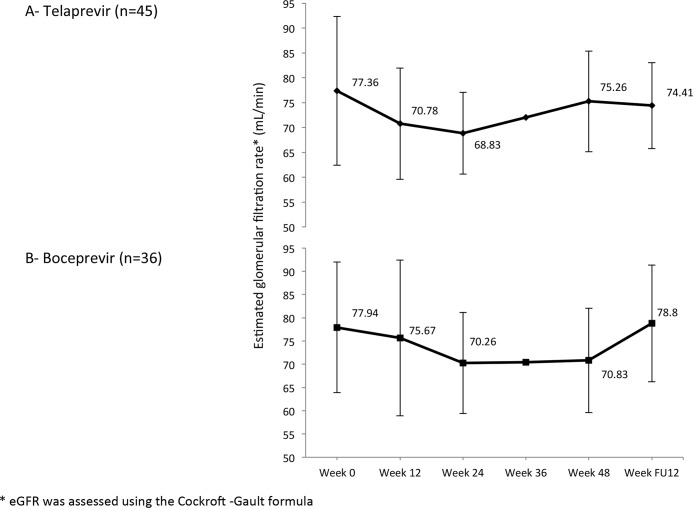
Mean estimated glomerular filtration rates during triple therapy.The median decrease of eGFR was 7.68mL/min with BOC and 8.53mL/min with TVR (P = ns). Seven patients were hospitalized because of acute kidney failure, six of whom were in the TVR group. No CNI overdoses were observed and all patients recovered after a saline infusion.